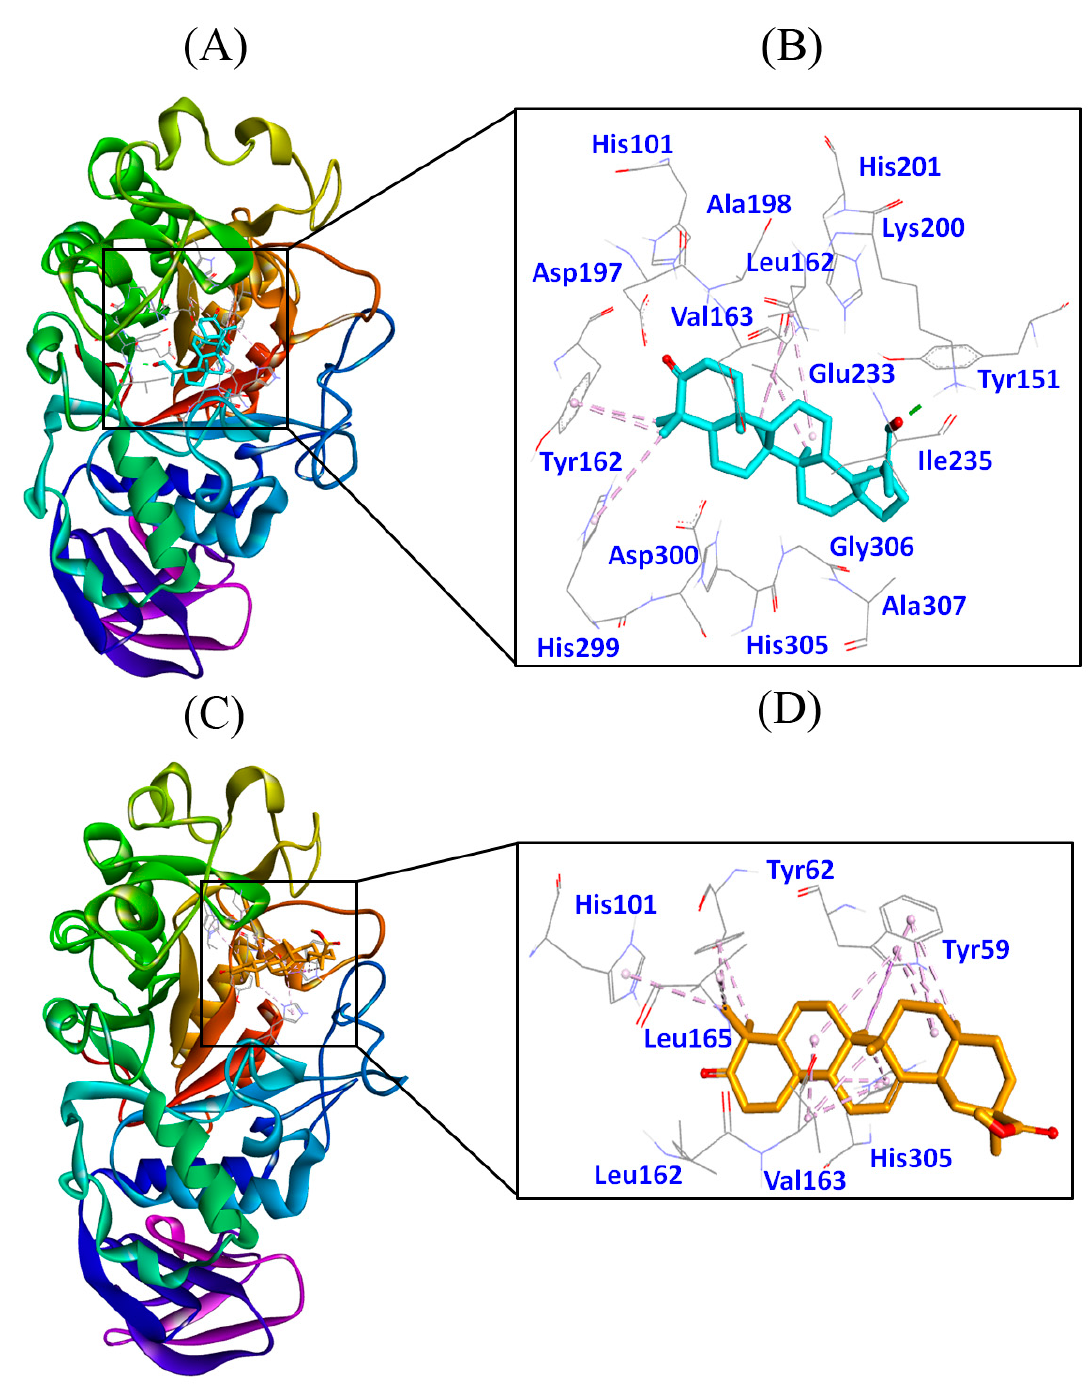
Figure 6. Molecular docking of 3-oxolupenal and katononic acid with α -amylase. ( A ) Binding of 3-oxolupenal with α -amylase, ( B ) amino acid residues and various interactions involved in 3-oxolupenal- α -amylase complex, ( C ) binding of katononic acid with α -amylase, and ( D ) amino acid residues and various interactions involved in katononic acid- α -amylase complex.